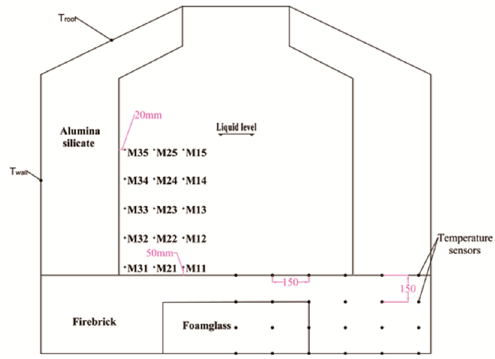
Figure 2. Insulation in the tank and the distribution of temperature sensors.